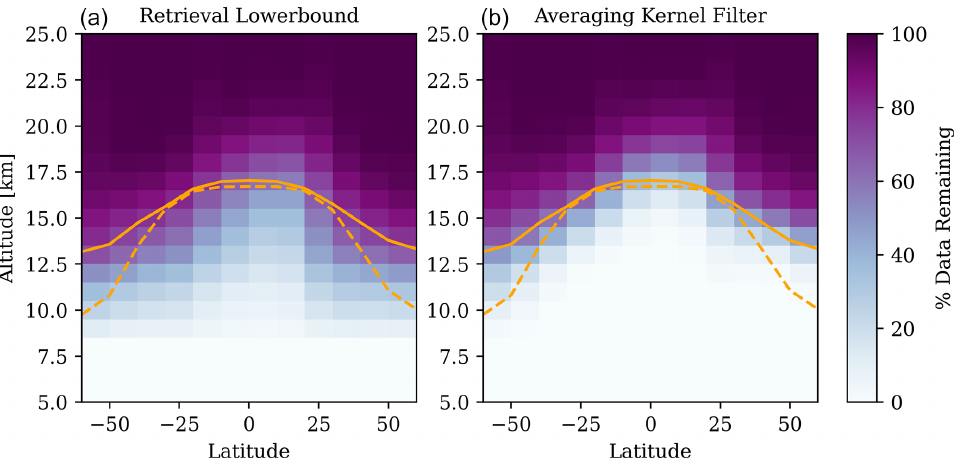
Figure 5. (a) The percentage of data that are retrieved and above the cloud top. (b) The percentage of data that remain after applying the averaging kernel filter. The solid orange line is the average altitude of the 380K potential temperature. The dashed orange line is the mean tropopause height based on the temperature lapse rate. The percentages were calculated for all OSIRIS profiles from 2010.